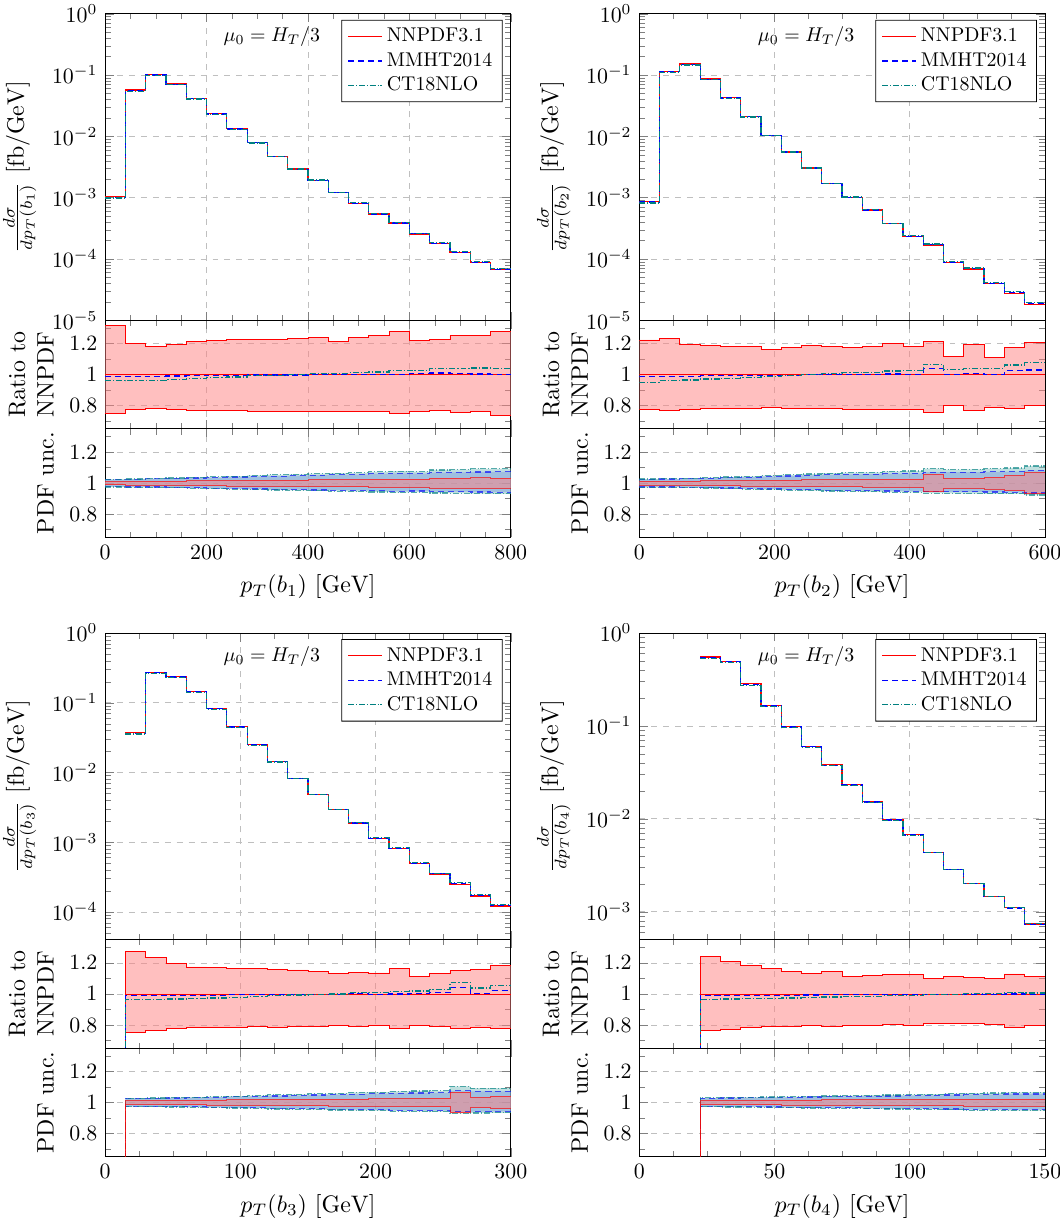
Figure 9 . NLO differential cross section distributions as a function of p T ( b 1 ) , p T ( b 2 ) , p T ( b 3 ) and p T ( b 4 ) . Results are shown for the pp → e + ν e µ − ¯ ν µ b ¯ b b ¯ b + X process at the LHC with Three different PDF sets are employed. Lower panels display the theoretical uncertainties from scales and PDFs. All predictions are normalised to the central NLO prediction with the NNPDF3.1 PDF